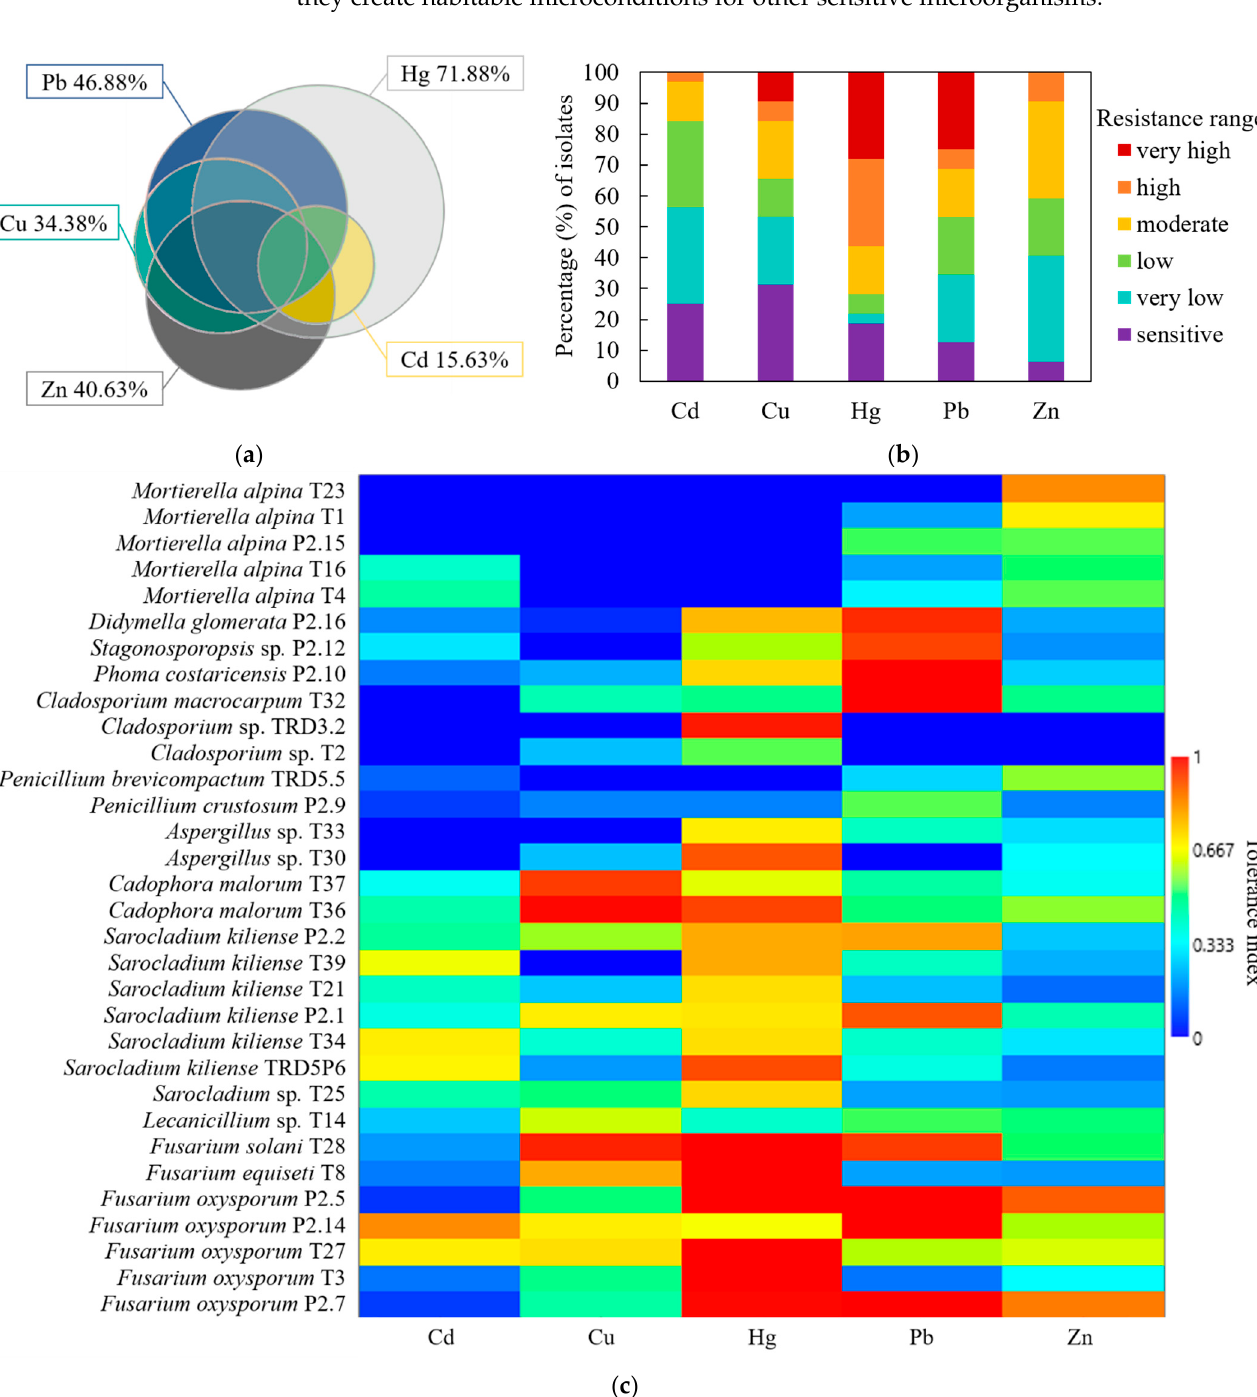
Figure 4. Fungi community, illustrated as percentages of isolates ( a ) with single and multiple metals resistance (TI ≥ 5), ( b ) according to tolerance index ranges, and ( c ) with matrix-plot of individual TI.